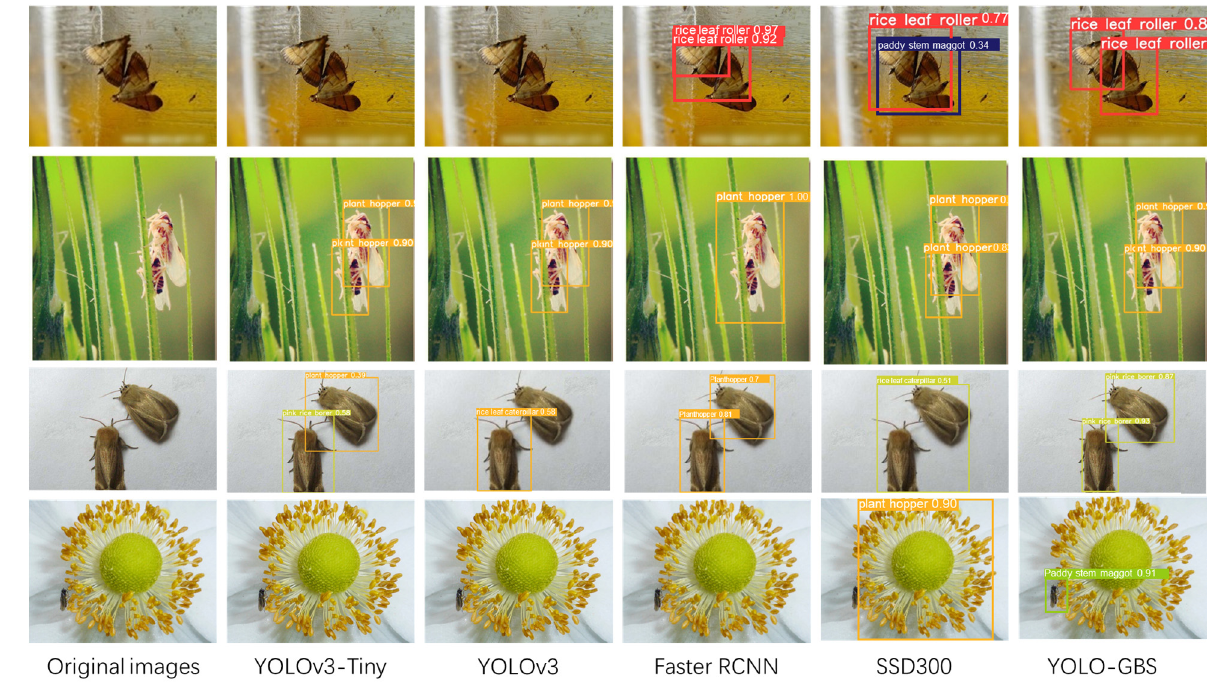
Figure 9. Visualization results.